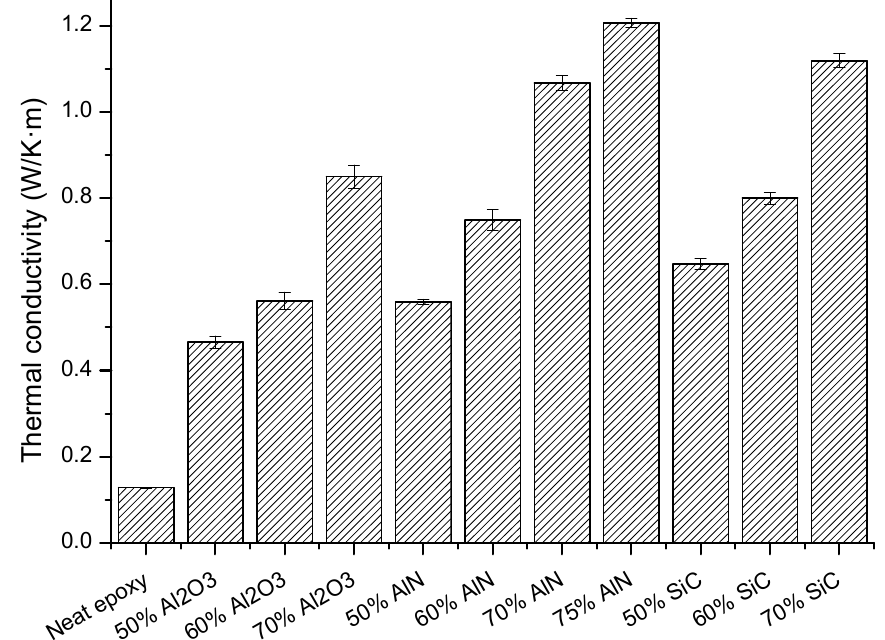
Figure 8. Thermal conductivities of the neat epoxy and the different composites prepared.